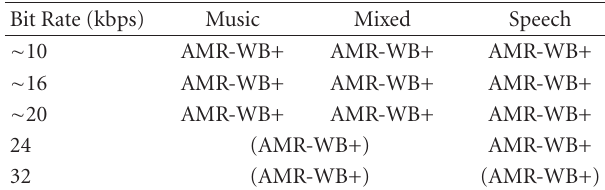
Table 2: Audio codec preference for di ff erent mono audio content types (Derived from characterization results in 3GPP TR 26.936. 24